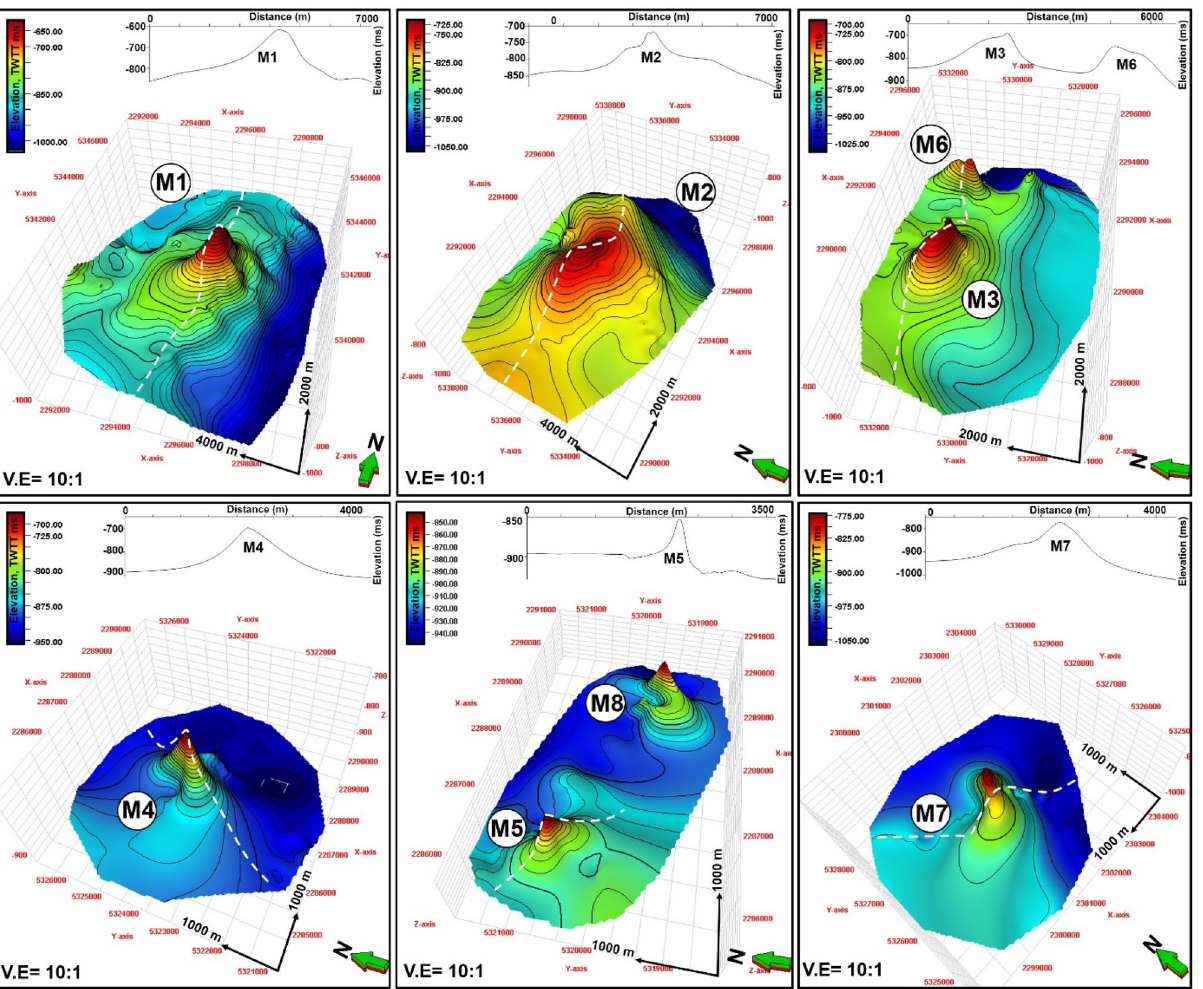
Figure 7. 3D map view and cross sections across mounds M1 to M8. The white line across the maps show the location of the cross sections displayed at the tops of each map. Contour spacing for the structural maps is 5 ms TWTT. TWTT: Two-way travel time in